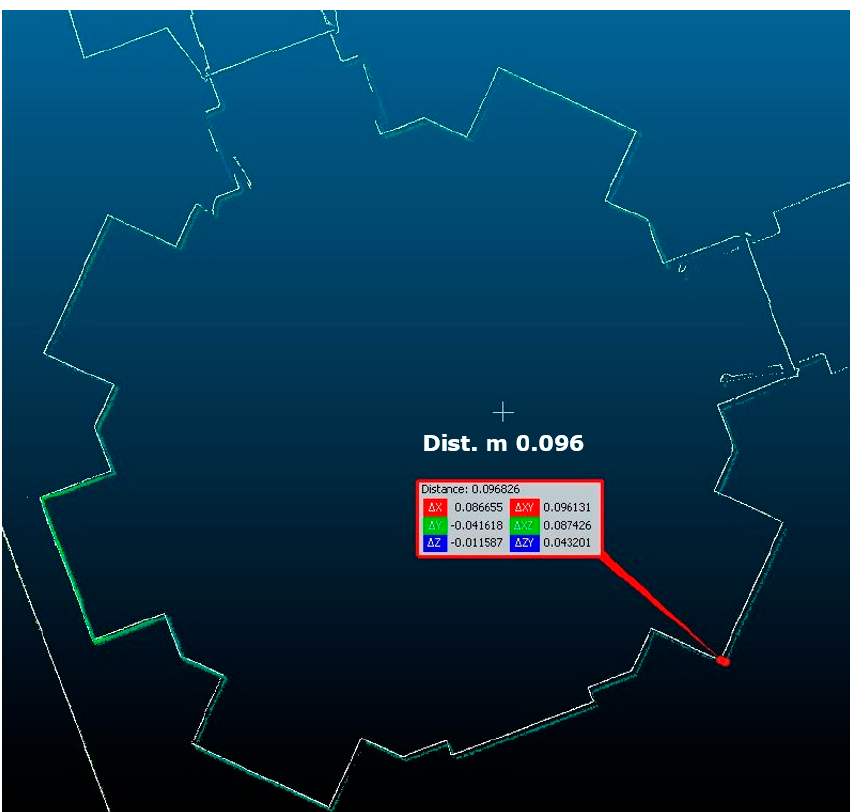
Figure 4. Path 1—Comparing datasets: Leica Pegasus in colour versus reference data in white. The horizontal section in the octagonal room (4.3 m above floor level) shows local misalignments.